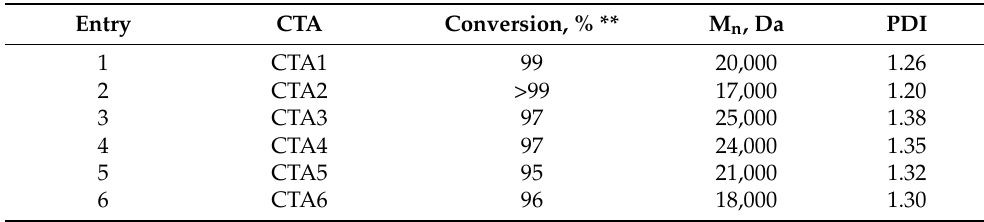
Table 1. The polymerization of 1-vinyl-1,2,4-triazole using CTA1–CTA6 in methanol at 60 ◦ C for 24 h,